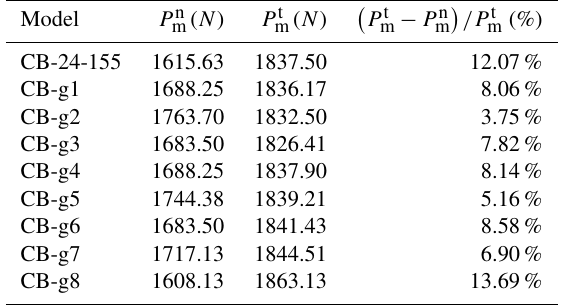
Table 3. Numerical and theoretical mean crushing force.